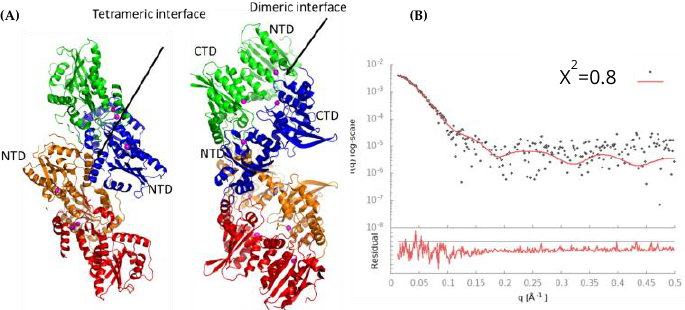
Figure 8. Tetramer model ( A ) featuring dimer and tetramer interfaces and fitting of this model (red solid line) with the SAXS scattering pattern (black dots) with residuals shown below ( B ). The right- hand image in ( A ) is rotated 90 ◦ clockwise about the line running from top to bottom to highlight the dimer interface. The dimer interface is that observed between pairs of A3G fl (6P40), and the tetramer interface is that observed between the NTD of pairs of A3G fl in 6P3X/Y/Z. Each monomer has its own color. The dimers of 6P40 were duplicated and overlaid with the 6p3x interface to produce the tertiary interface.